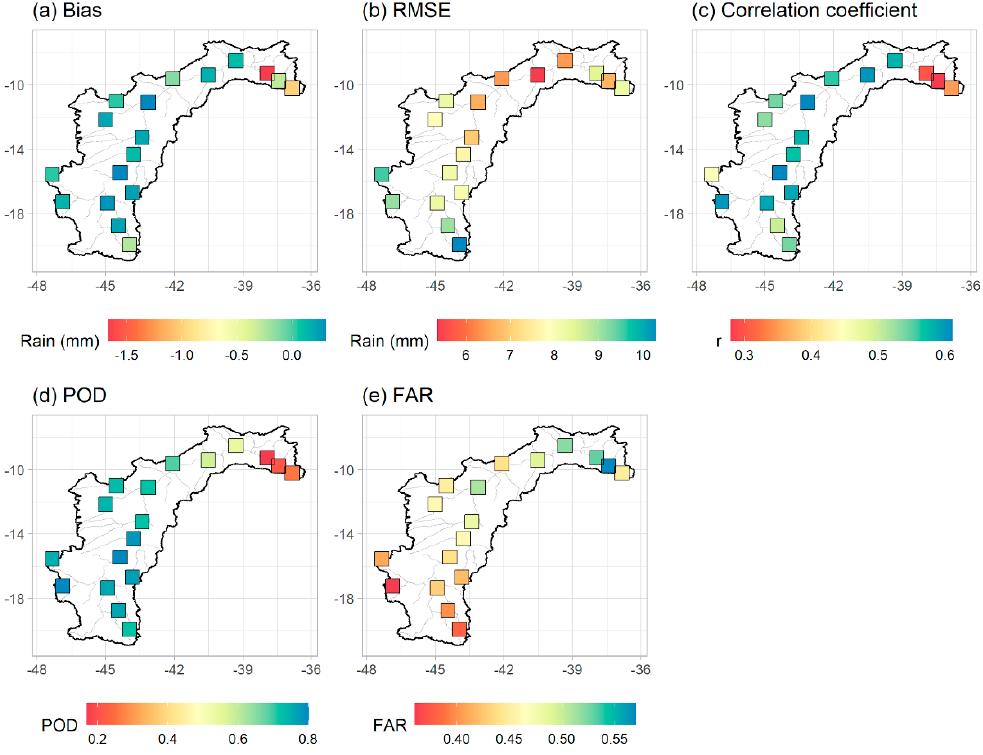
Figure 3. Spatial distributions of ( a ) BIAS, ( b ) RMSE, ( c ) correlation coefficient (r), ( d ) POD and ( e ) FAR.